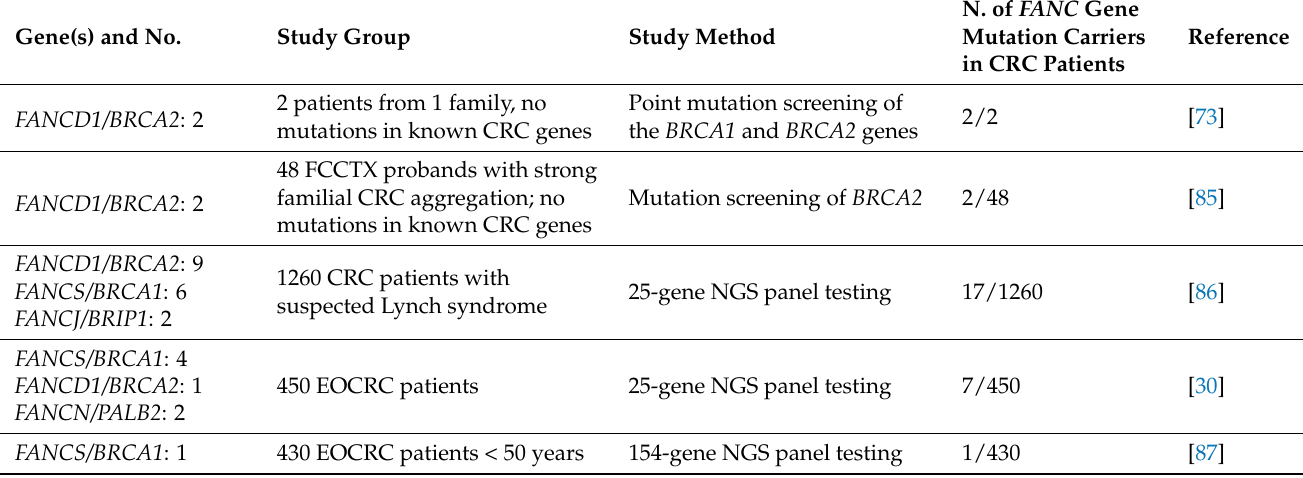
Table 1. Germline mutations in FANC genes among CRC patients without mutations in known CRC predisposition